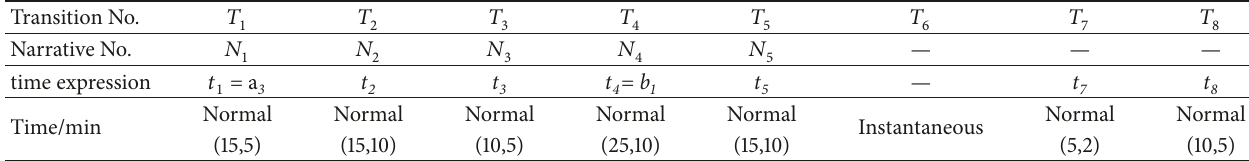
Table 3: Time characteristics of the